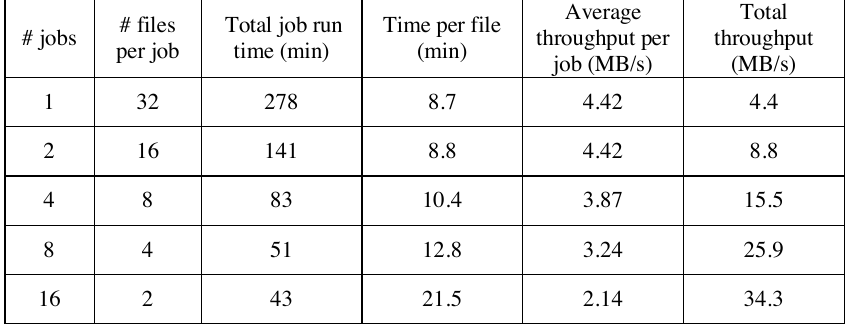
Table 2. Tests of increased parallelization, with mean averages over multiple runs where